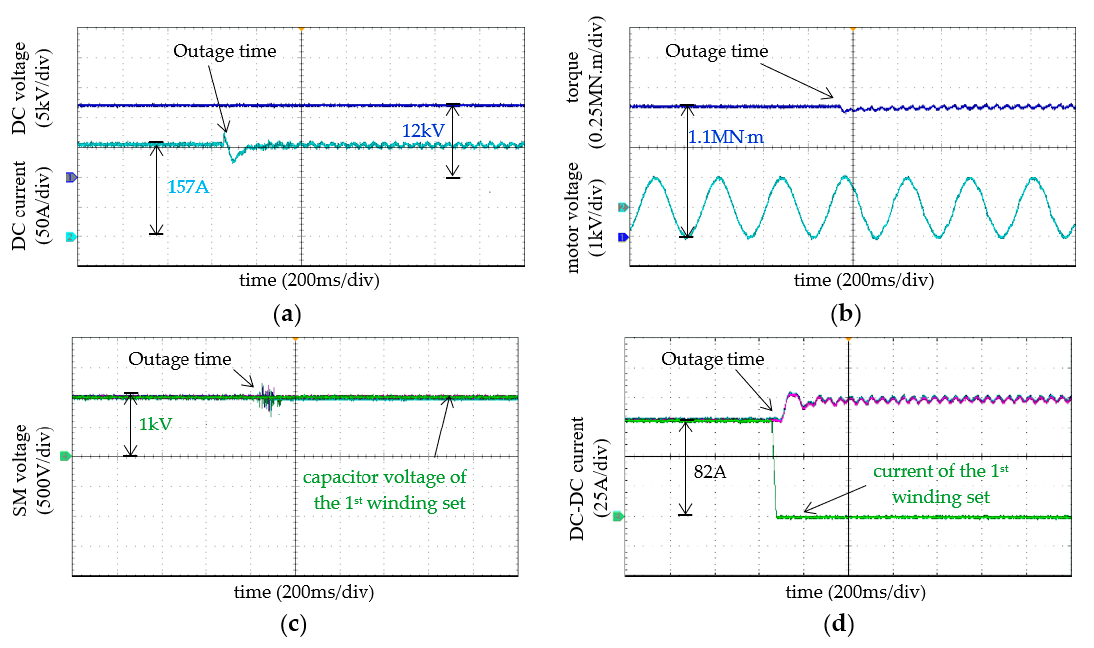
Figure 11. Experiment results when one set of three-phase winding was open circuited; ( a ) DC transmission voltage and current; ( b ) Terminal voltage of PMSG and electromagnetic torque; ( c ) SM capacitor voltages; ( d ) Currents of DC–DC converters.